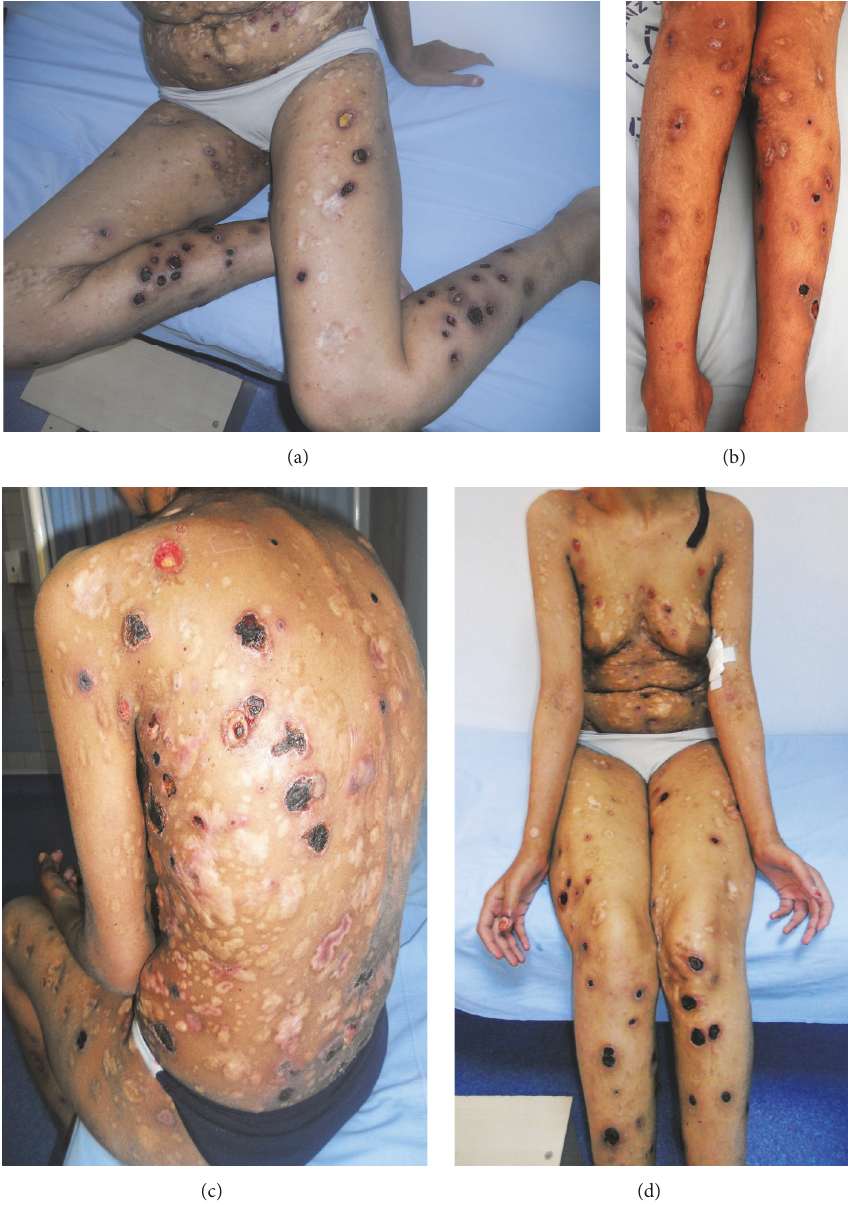
Figure 1: (a, b, c, d) Erythematous papules, plaques, hemorrhagic ulcerations, and atrophic scars in different sizes scattered all over the